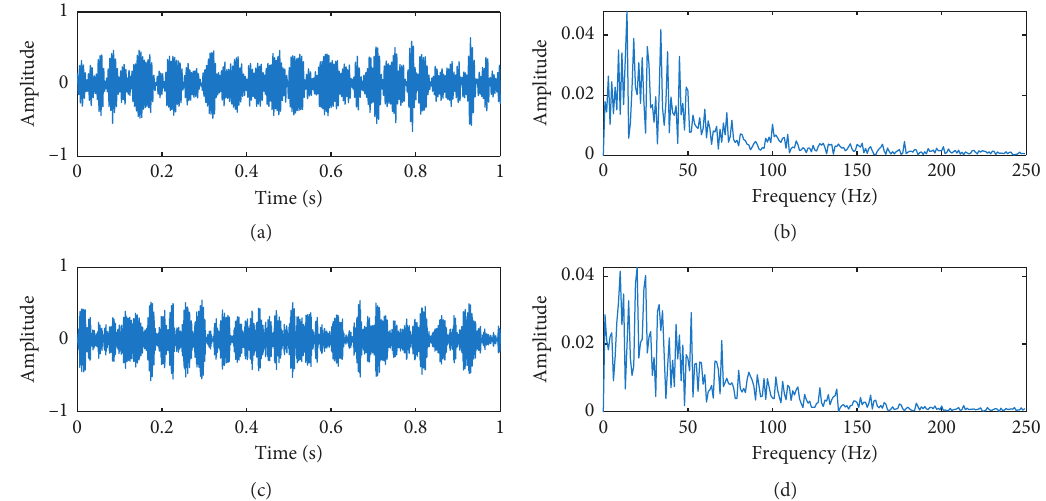
Figure 12: Results of the simulation signal in Figure 6(b) by different methods: (a) optimal mode extracted by the fixed-parameter VMD and (b) its envelope spectrum; (c) optimal mode extracted by PSO-based VMD and (d) its envelope